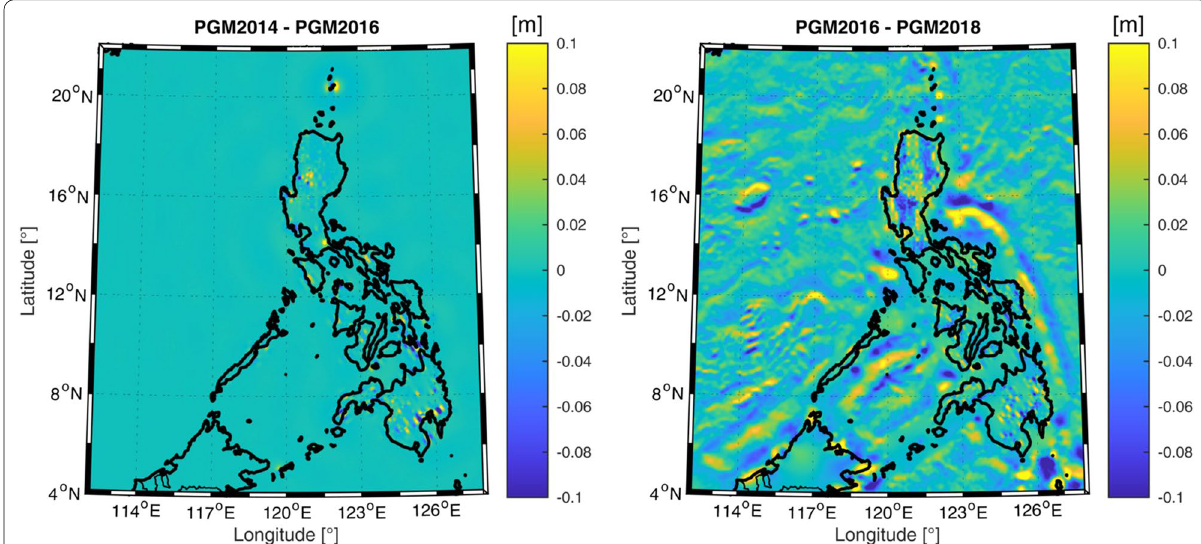
Fig. 1 Residuals of the comparisons among the models of the PGM gravimetric geoid series. The colour bars are saturated in the range between 0.1 m and 0.1 m −